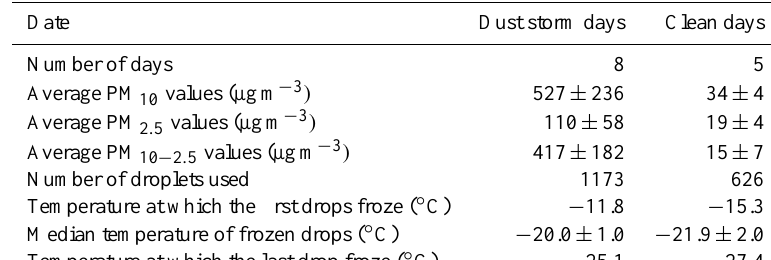
Table 3. Summary of clean and dust storms conditions.